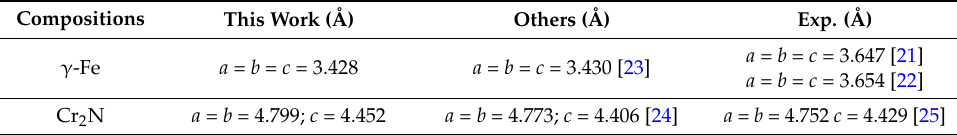
Table 1. Calculated lattice constants between them and experimental data for γ -Fe and Cr 2